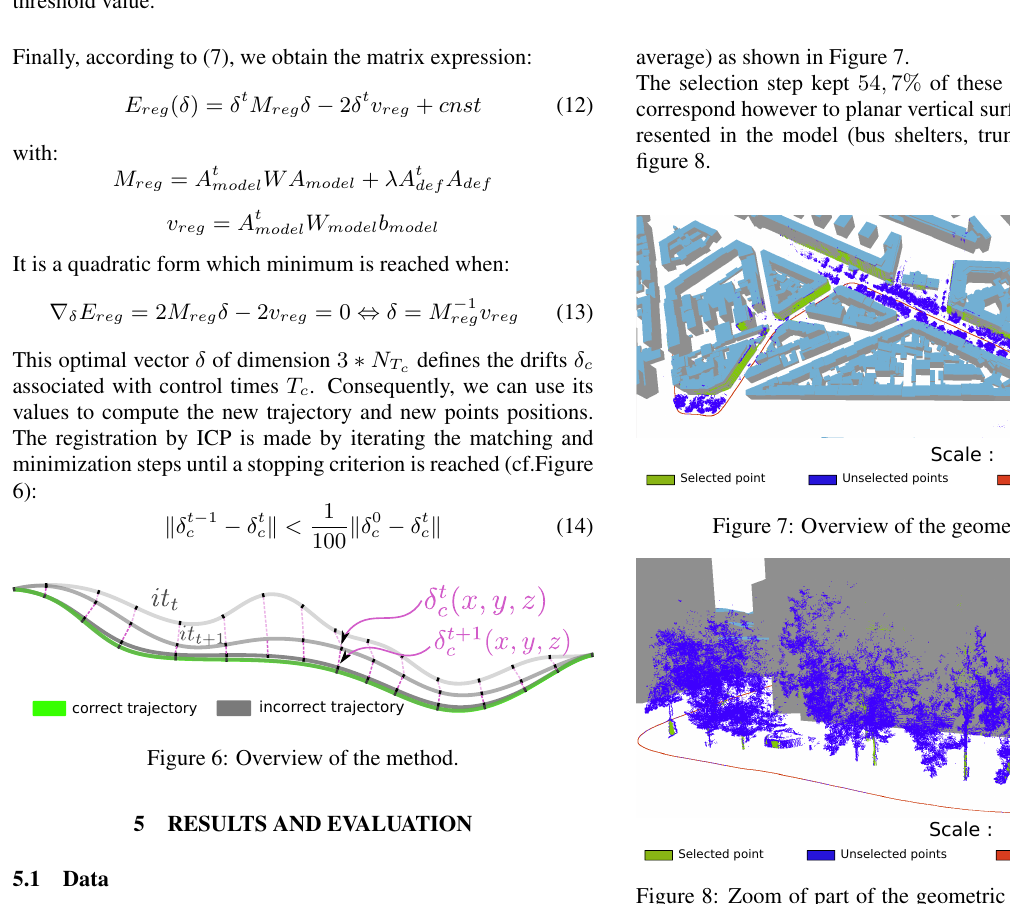
Figure 5: Illustration of the selection point process. (a) All façade points selected by the local geometrical descriptor. (b) Ray-tracing step: a point is selected only if the beam intersects a primitive. (c) Normal compatibility step: a point is selected if its normal is consistent with the primitive normal. (d) Distance acceptance: a point is selected only if its distance to the primitive is lower than a threshold value.